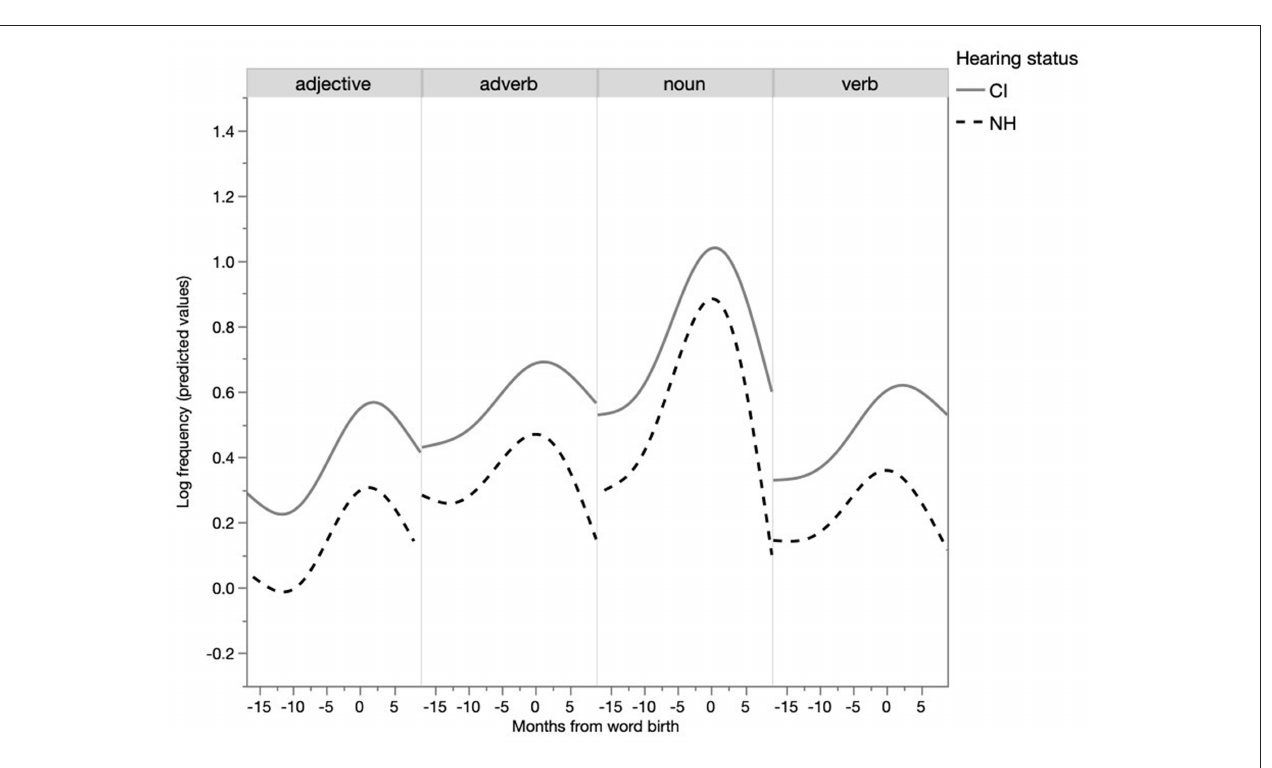
FIGURE 6 | Log frequency of isolated words in IDS per word class (predicted